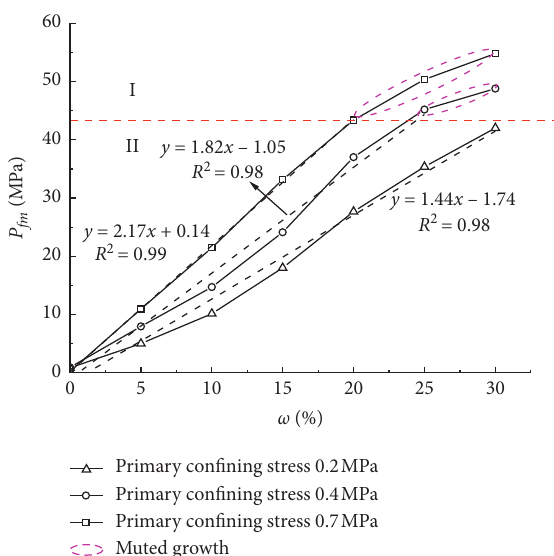
Figure 10: Variation of the internal interface stress peak with the expansion agent content under different confinement schemes.